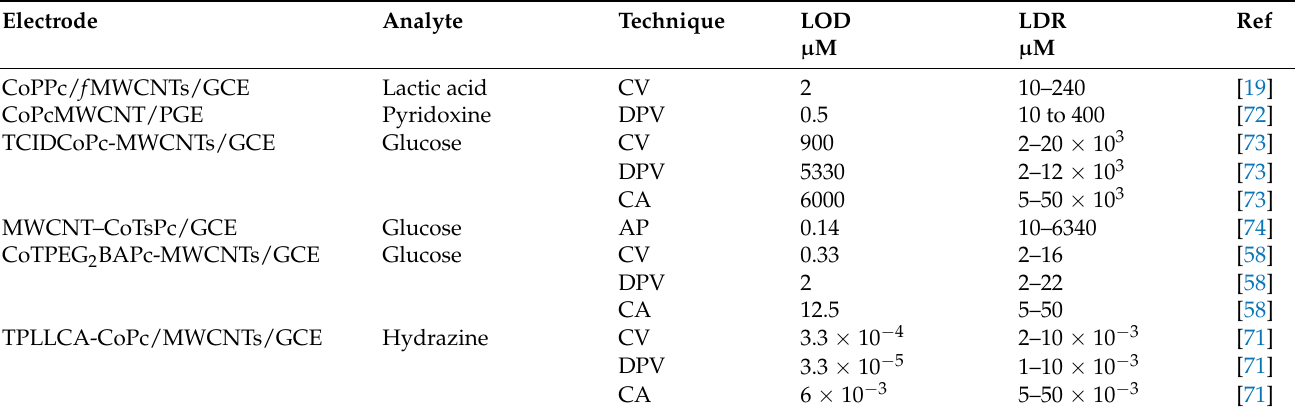
Table 5. Detection of glucose, hydrazine, lactic acid, and pyridoxine with CoPc-MWCNTs modified